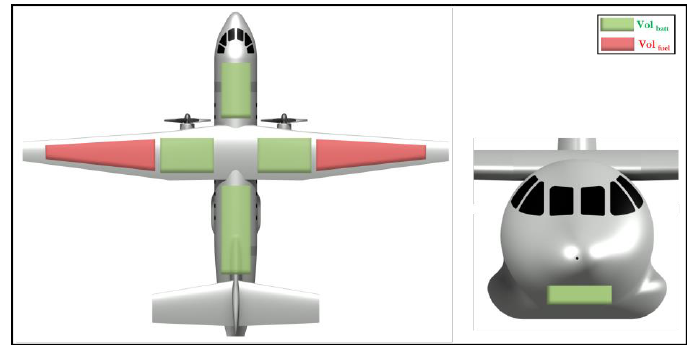
Figure 3. Qualitative scheme of fuel and battery available volume